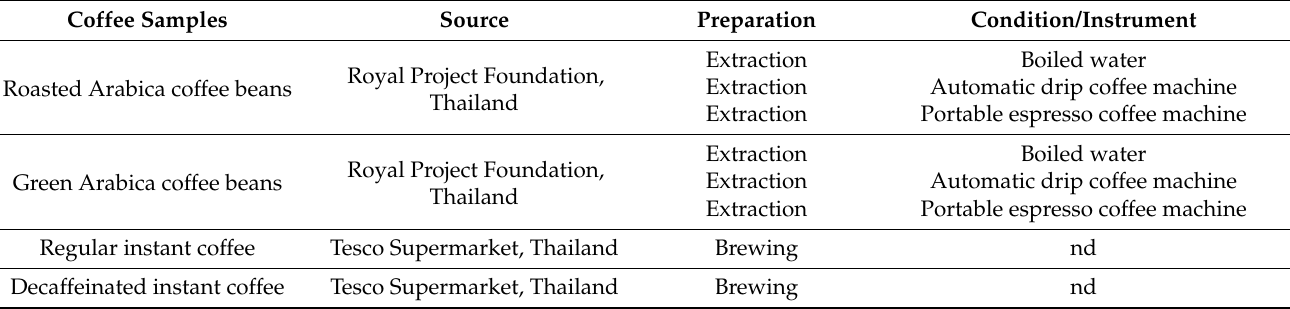
Table 1. Description of all coffee samples used in the